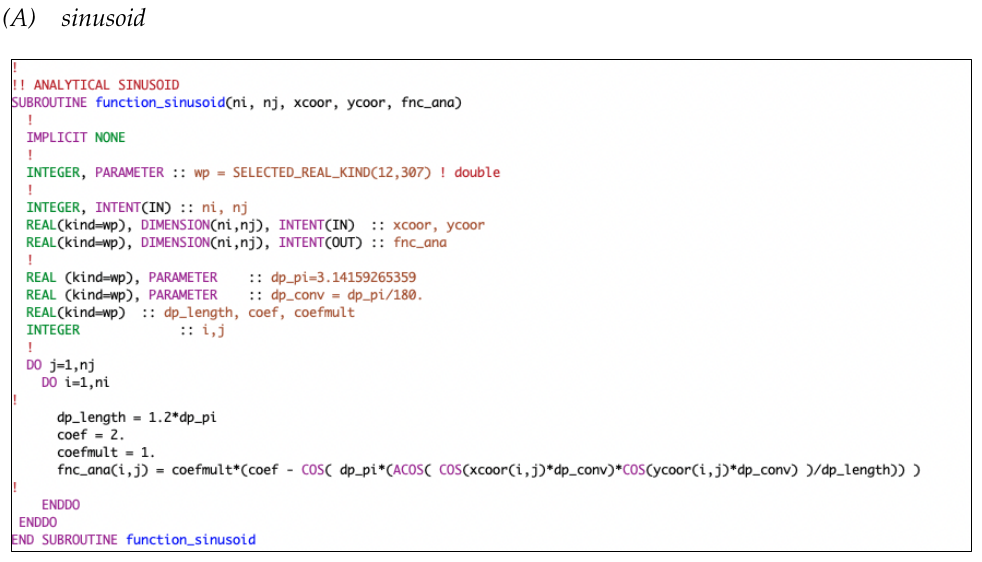
Figure A1. Fortran 90 code defining the sinusoid analytical function.